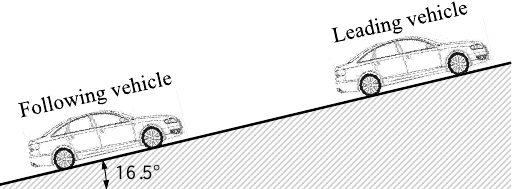
Figure 10. The sloping road environment for forward collision avoidance, adaptive cruise, or platooning.